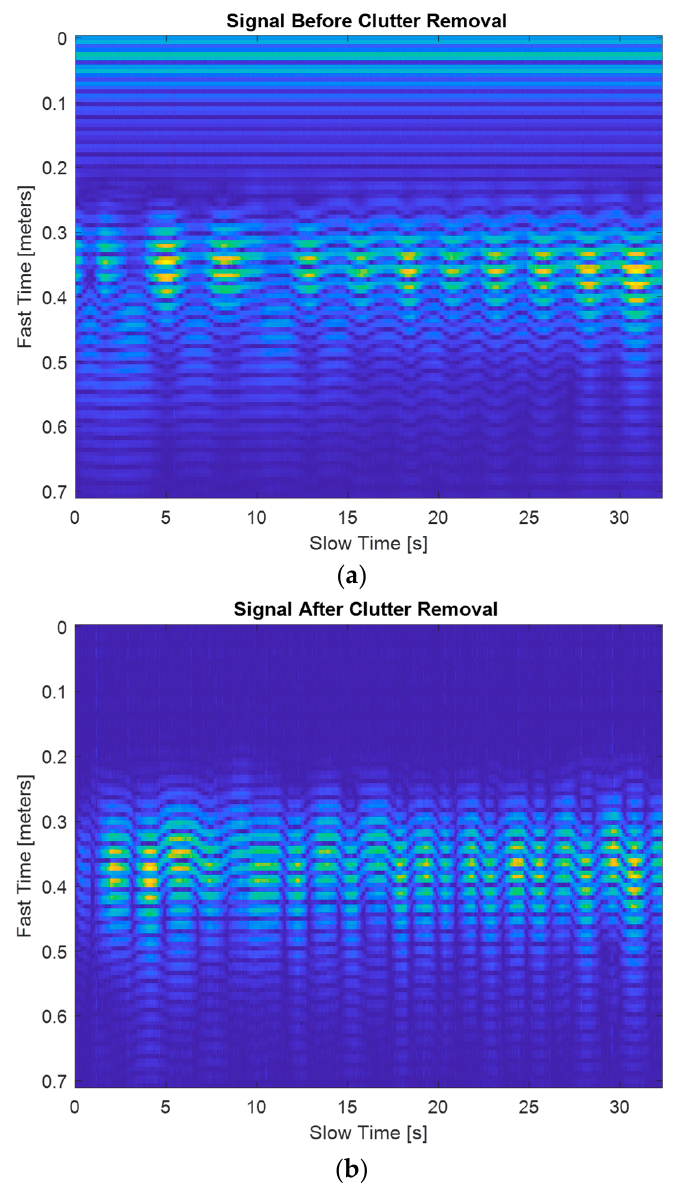
Figure 2. Raw signal received from a human target ( a ) before and ( b ) after clutter removal filter.